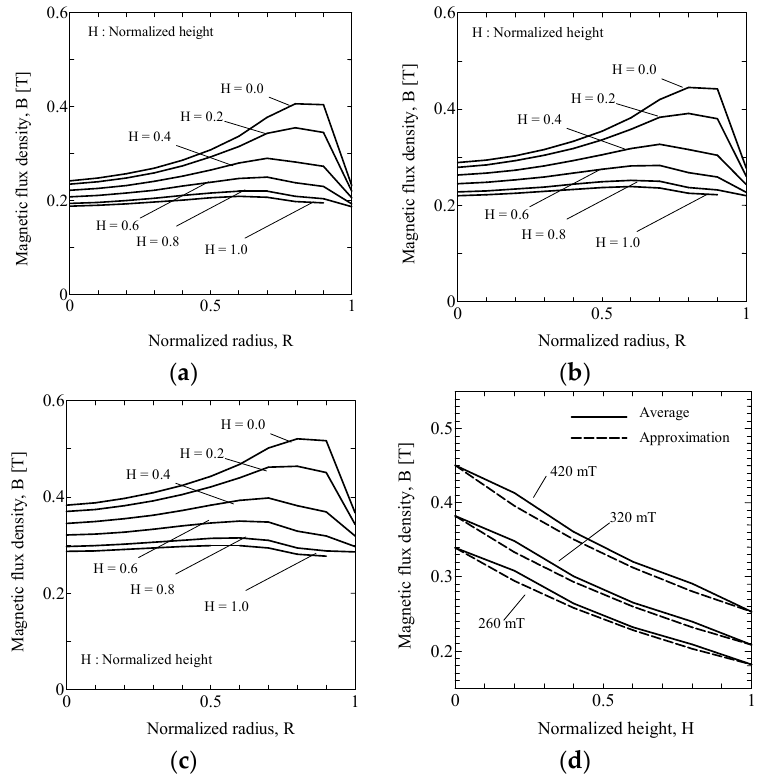
Figure 3. Non-uniform MFs in MREs with PMs of: ( a ) 260 mT; ( b ) 320 mT; ( c ) 420 mT; ( d ) averaged MF distributions for each PM.